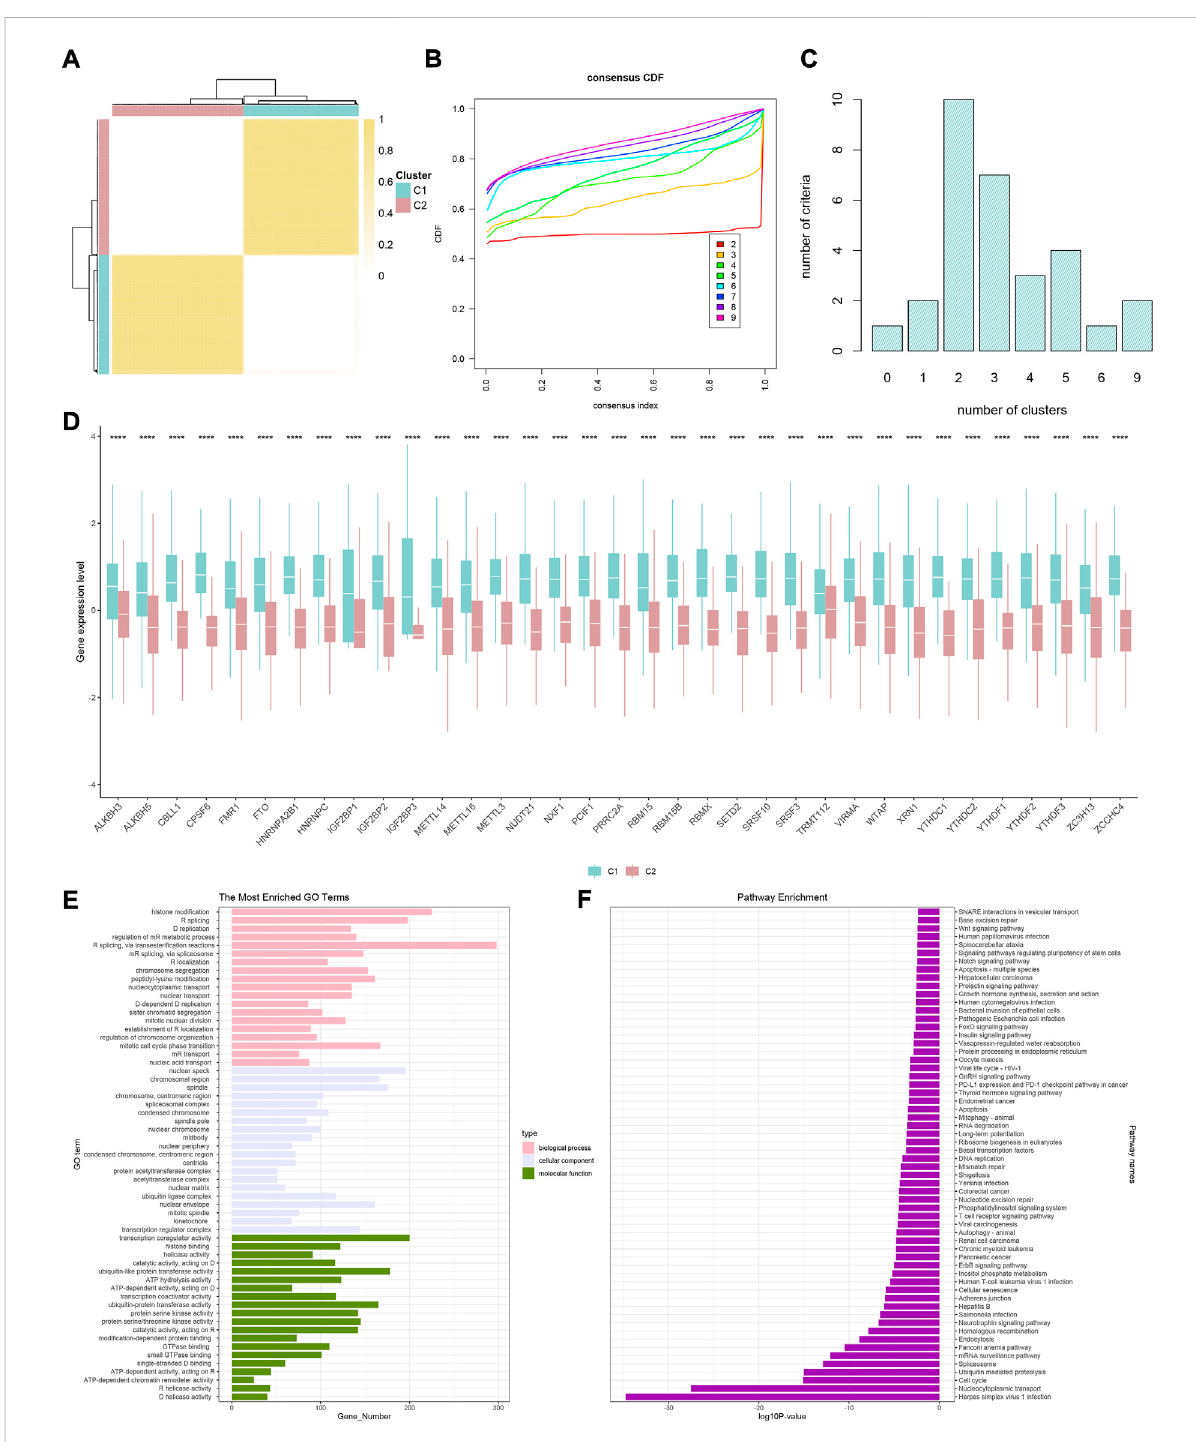
FIGURE 3 Two genomic subtypes of differentially expressed genes that can affect a cancer patient ’ s prognosis using unsupervised cluster analysis. (A) Consensus matrix when k = 2. (B) CDF graph of the consensus matrix for each k (indicated by colors). (C) Optimal cluster number by K-means clustering and program NbClust. (D) Difference intheexpression level of35m6A regulators betweentwogeneclusters (* p < 0.05, ** p < 0.01,*** p < 0.001, **** p < 0.0001, and ns, not signi fi cant). (E) GO enrichment analysis. (F) KEGG enrichment